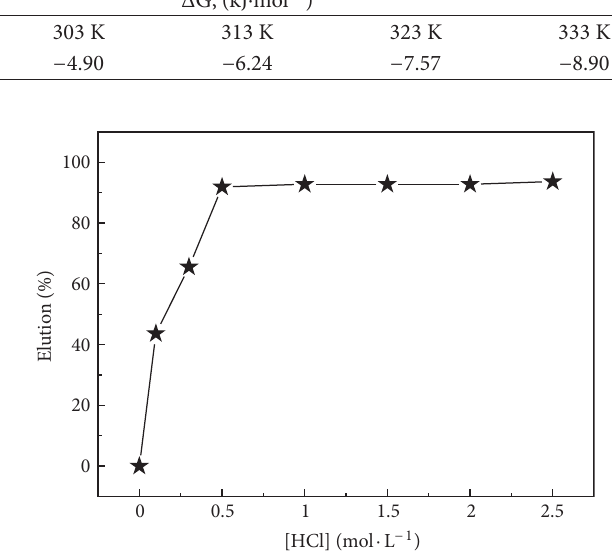
F 12: Effect of HCl concentration on the desorption of Cd(II) loaded on graed resin. Loaded resin quantity: 0.030g, acid volume: 5mL, and time contact: